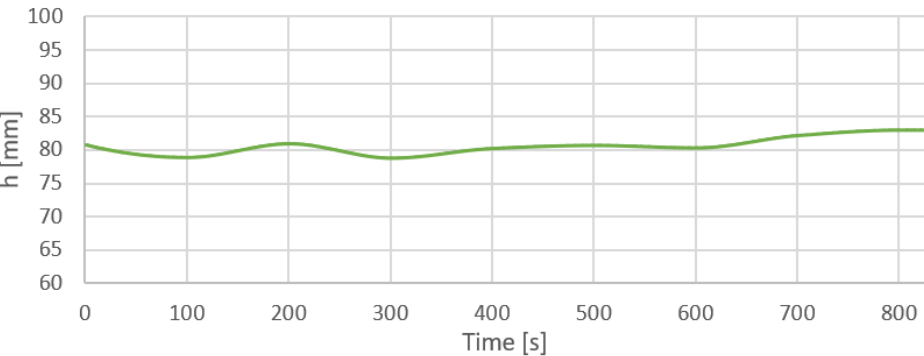
Figure 9. Waveform of changes in the position of the distribution layer in compartment 2 when using the fuzzy controller.